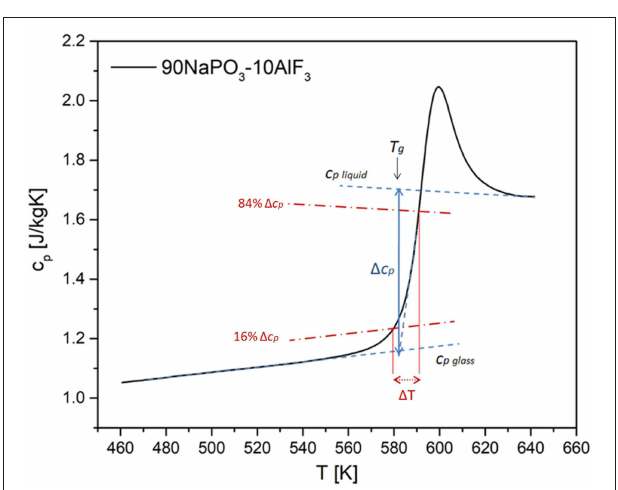
FIGURE 12 | Scheme for the determination of the quantities needed for the calculation of the CRR volume based on specific heat measurements using